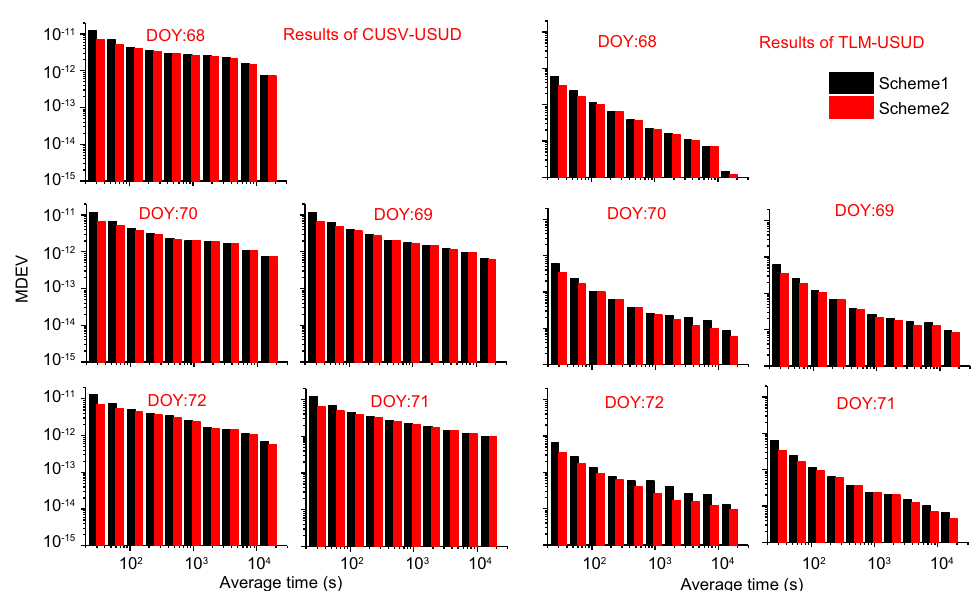
Fig. 15 MDEV of CUSV-USUD and TLM2-USUD from BDS-3/GPS PPP in Scheme 1 and Scheme 2